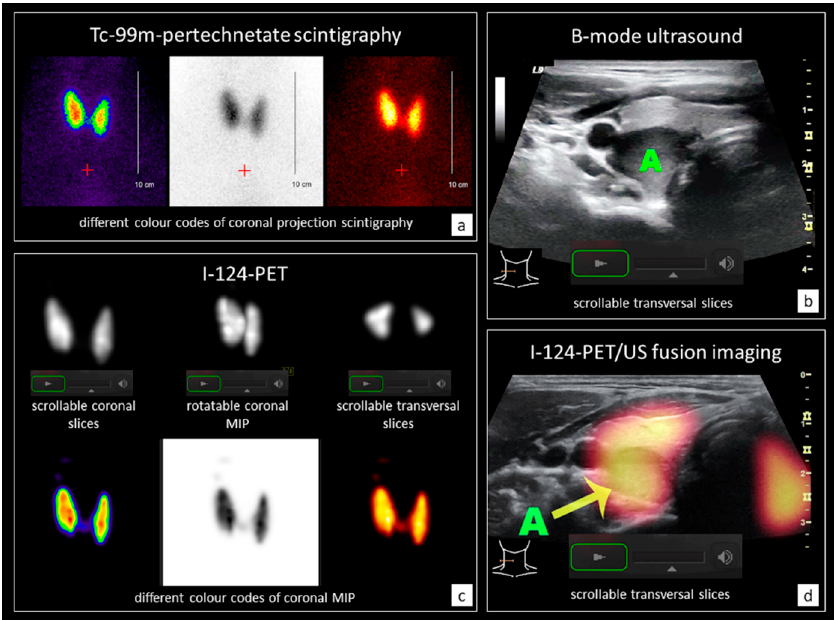
Figure 4. Exemplary extracts from a digital patient case file (PCF) of a 34-year old female with a single thyroid nodule (23 × 14 × 13 mm, 2.0 mL) in the right-sided thyroid lobe. ( a ) Tc-99m-pertechnetate scintigraphy in coronal orientation presented in three different colour codes (spectrum, inverted grayscale, and hot body); ( b ) Scrollable B-mode ultrasound (US) of the right lobe in transversal orientation. The solitary dorsal nodule is marked (A). ( c ) I-124-PET images of the thyroid presented in scrollable coronal and transversal slices as well as in a rotatable coronal maximum intention projection (MIP) in grayscale in the upper row. Furthermore, coronal orientated MIPs in three different colour codes (spectrum, inverted grayscale, and hot body) are presented in the lower row. ( d ) Scrollable I-124-PET/US fusion images of the right lobe in transversal orientation. The solitary dorsal nodule is marked (A). In the PCF with conventional diagnostics only (CDonly), this dorsally located nodule was prevailingly rated as indifferent with uncertain confidence by nuclear medicine physicians (medical doctors, MD) and as not rateable by medical students (MS). In the PCF with additional I-124-PET/US fusion imaging (CD+PET/US), all observers rated the nodule as indifferent with absolute or quite certainty. The entire PCF presented to the observers included further images such as transversal- and sagittal-orientated images of the whole thyroid on both B-mode US and I-124-PET/US fusion imaging, as well as further clinical data such as the thyroid volume (15 mL, right lobe: 10 mL, left lobe: 5 mL), the Tc-99m-uptake (2.02%, right lobe: 1.16%, left lobe: 0.86%), the blood levels (TSH-level: 3.6 mU/l, no pathological antibodies), and symptoms (globus sensation).